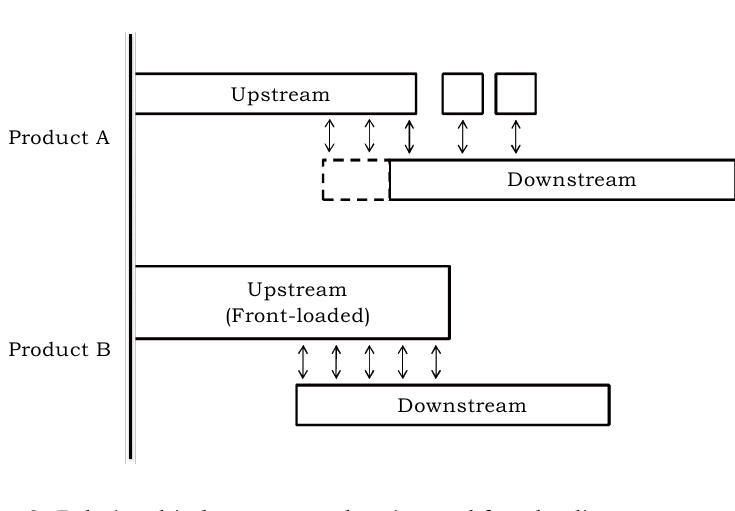
Figure 3. Relationship between overlapping and